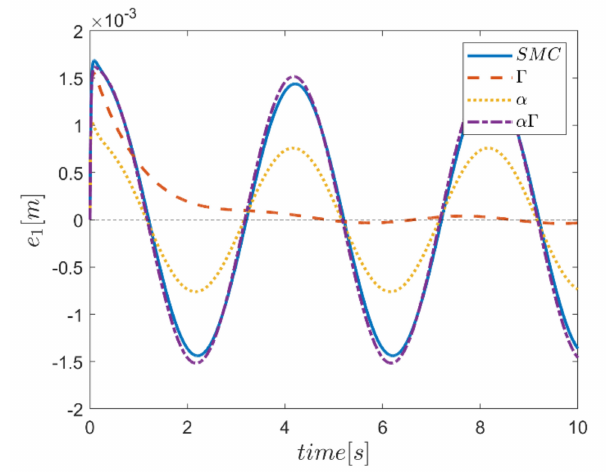
Figure 18. Tracking error in the x channel.